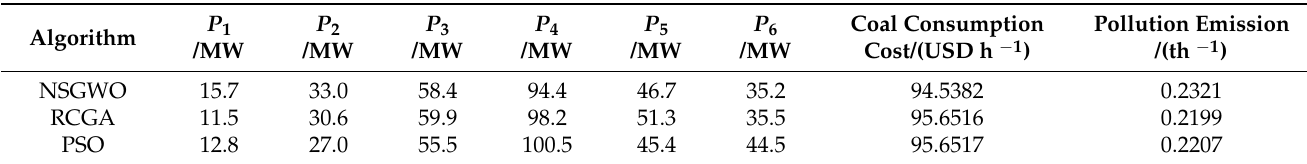
Table 6. Optimization results of economic load dispatch for coal-fired power plant without valve- point effect of steam